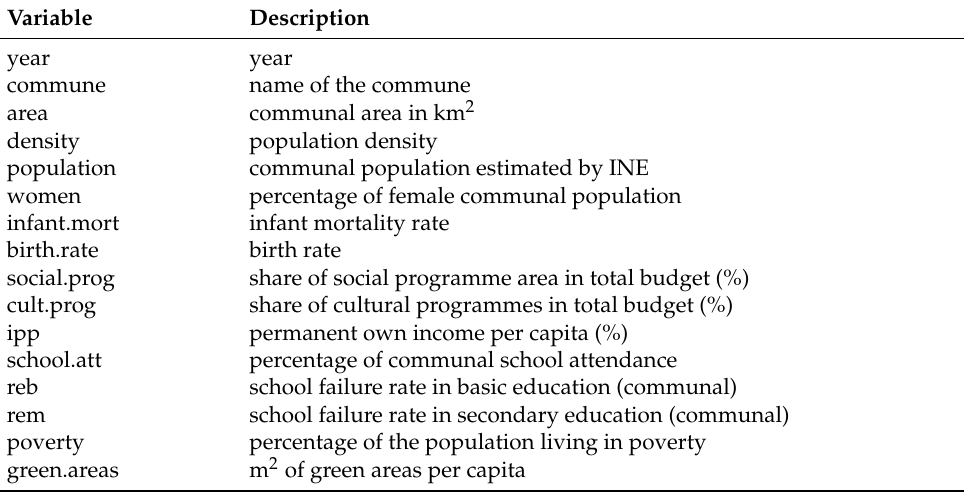
Table 3. Covariables containing information about the communes.